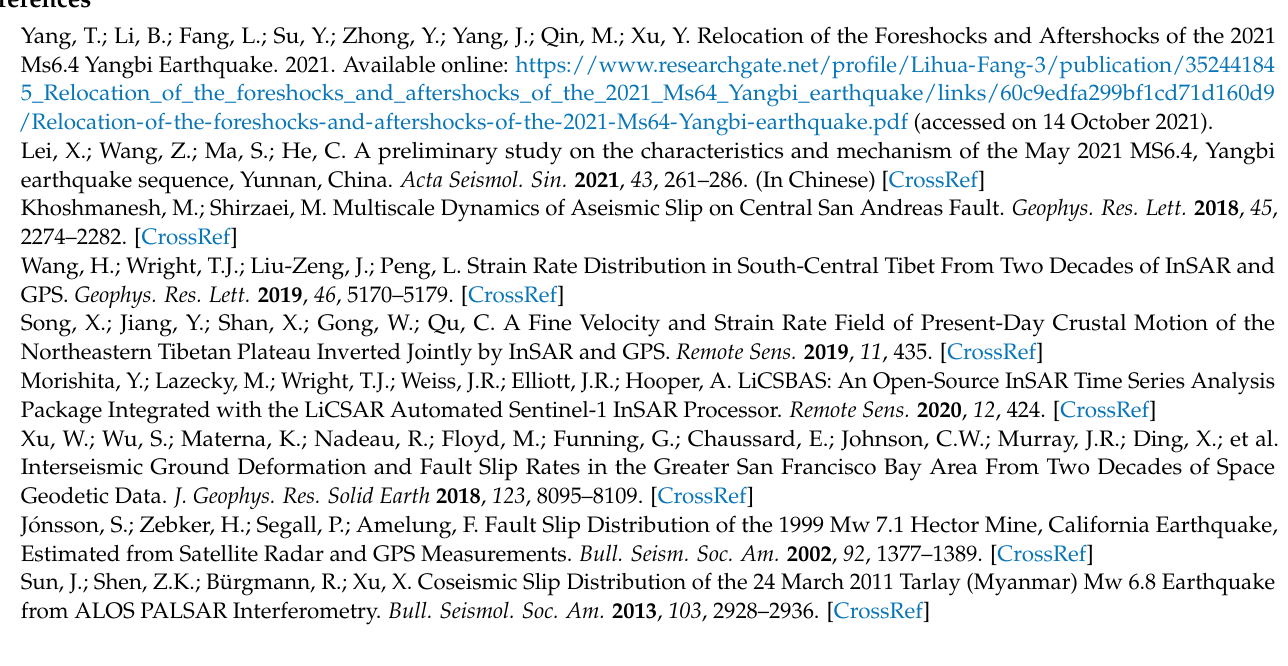
orbital errors corrections, Figure S2: Downsampled InSAR observations, Figure S3: Statistics of the faulting geometric parameters obtained by non-linear inversion, Figure S4: The spatial relationship between the faulting geometry and the aftershocks, Figure S5: The tradeoff curve between the residual and the roughness, Figure S6: Simulated and residual interferograms generated by model-A, Figure S7: Simulated and residual interferograms generated by model-D, Table S1: 1. Preferred faulting geometric parameters obtained by non-linear